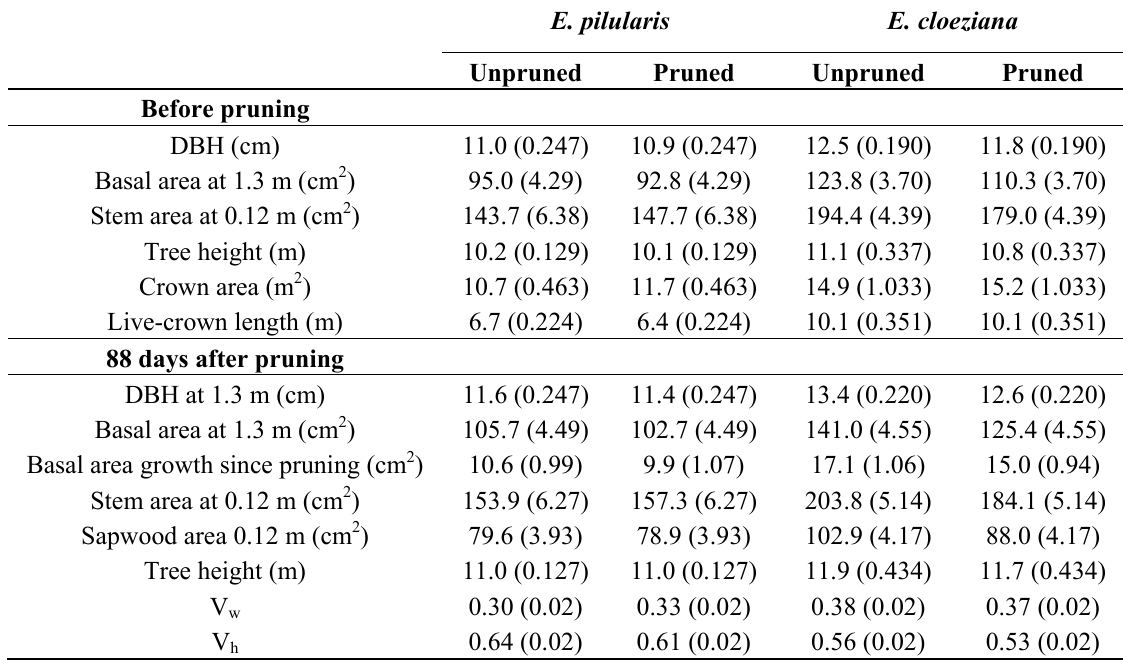
Table 1. Summary of tree characteristics measured about two weeks before and 88 days after pruning. Sapwood area and width and the volume fractions of wood (V ) were measured at the probe insertion height (0.12 m). For a given species and variable (V h no differences were significant ( P > 0.05). Values in parentheses refer to standard errors of